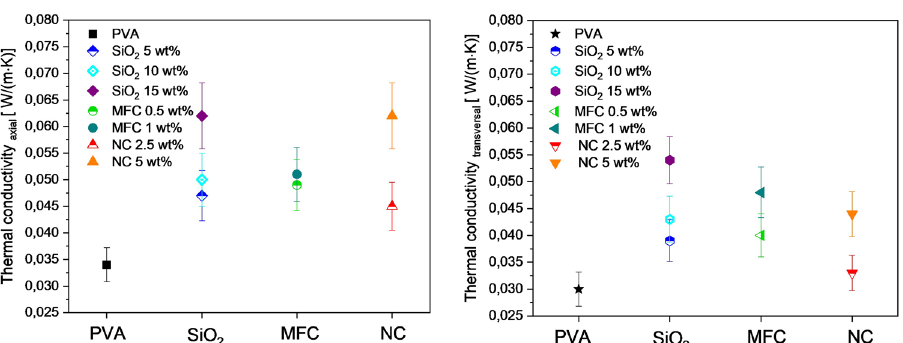
Figure 3. Thermal conductivities (calculated from the measured thermal diffusivity) in axial (left) and transversal (right) direction of the composites with 5 wt.% PVA. Pure PVA scaffolds (square and star black symbols), PVA/SiO 2 composites (rhombus and hexagon blue, cyan and purple symbols), PVA/MFC composites (dark green and green circle and pointing left triangles) and PVA/NC composites (red and orange pointing un and pointing down